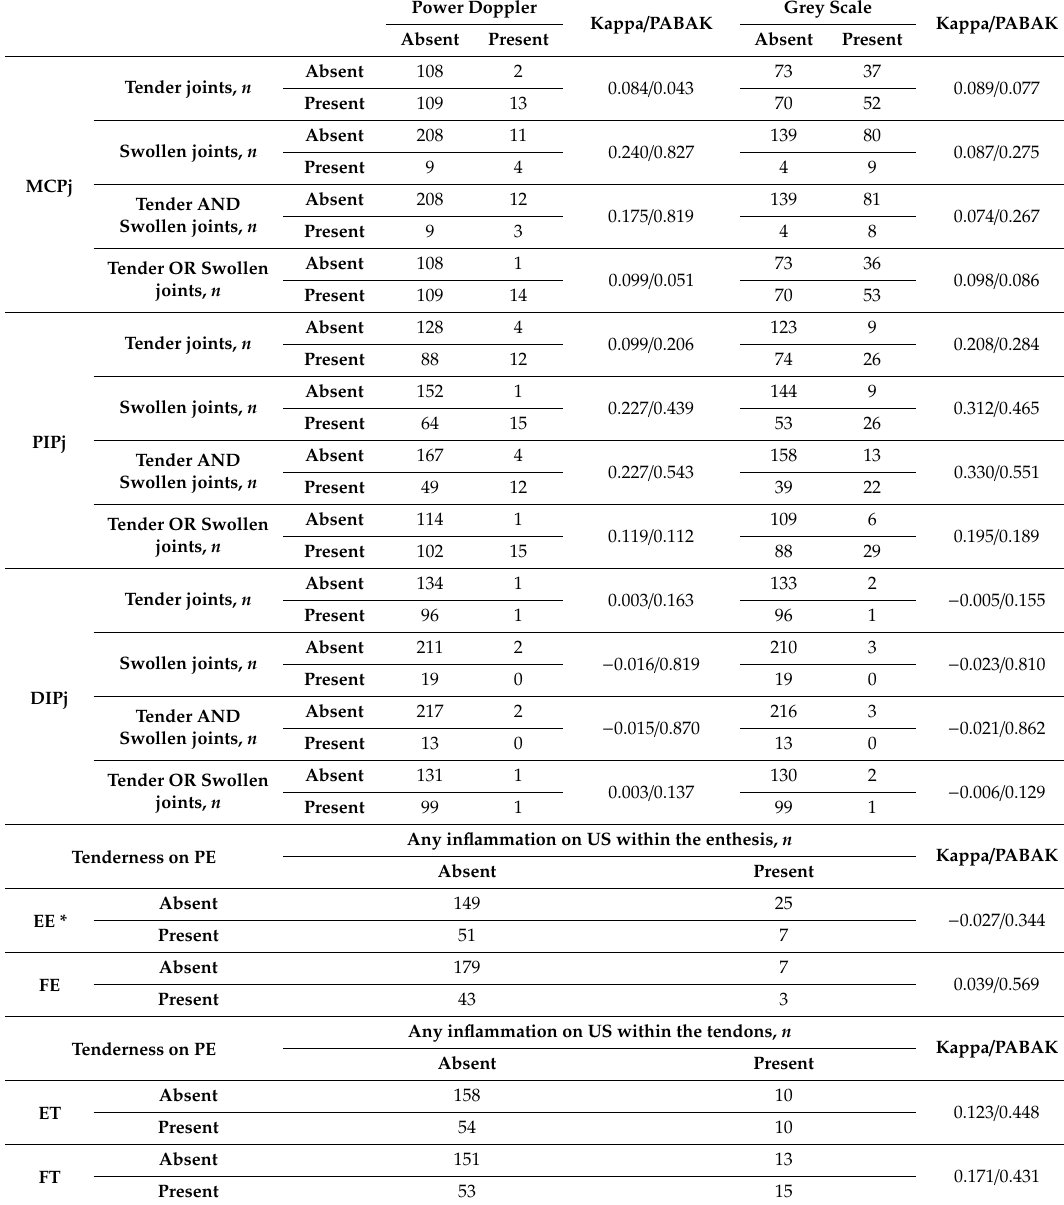
Table 3. Agreement of physical examination and ultrasonography in joints, enthesis, and